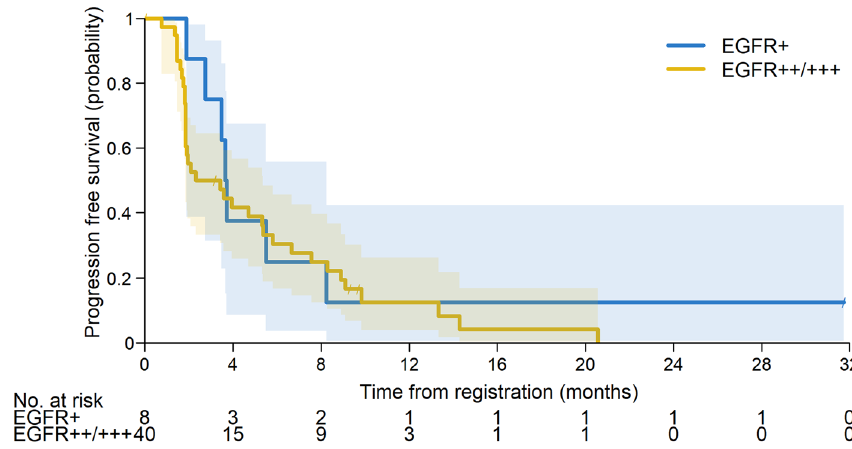
Figure 3. Progression free survival in the full analysis set according to EGFR status.